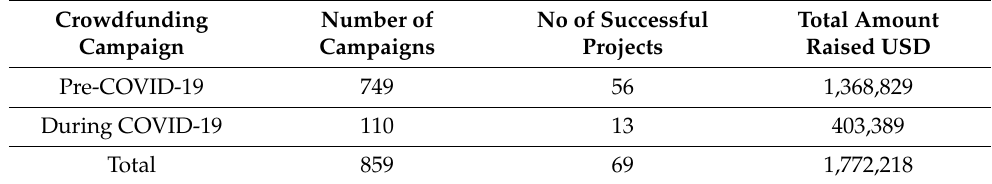
Table 5. Trends in Crowdfunding